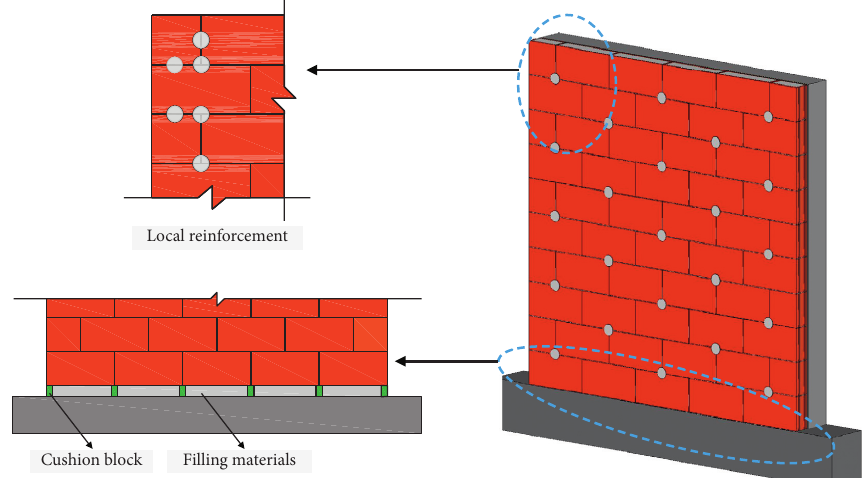
Figure 13: Design